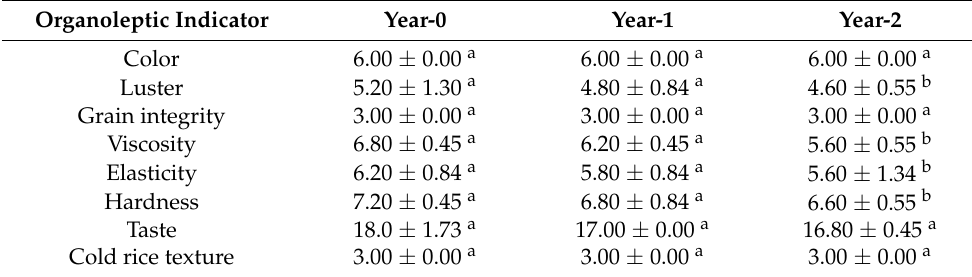
Table 1. Rice edible quality variation during different storage time.